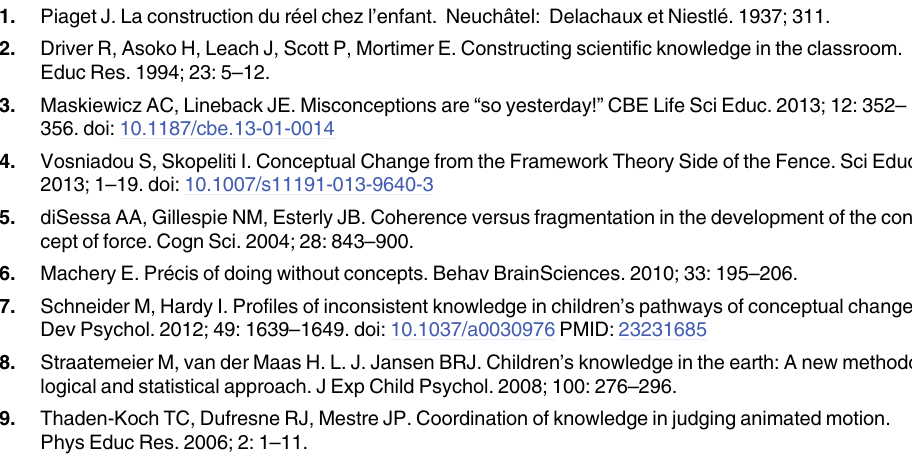
S1 Table. Sample description class-divided according to educational background (n = 885). S2 Table. Categories per level of conception within question A and B. S3 Table. Sex Effect on scientific and alternative concepts. S4 Table. Conception levels in comparison between question A and